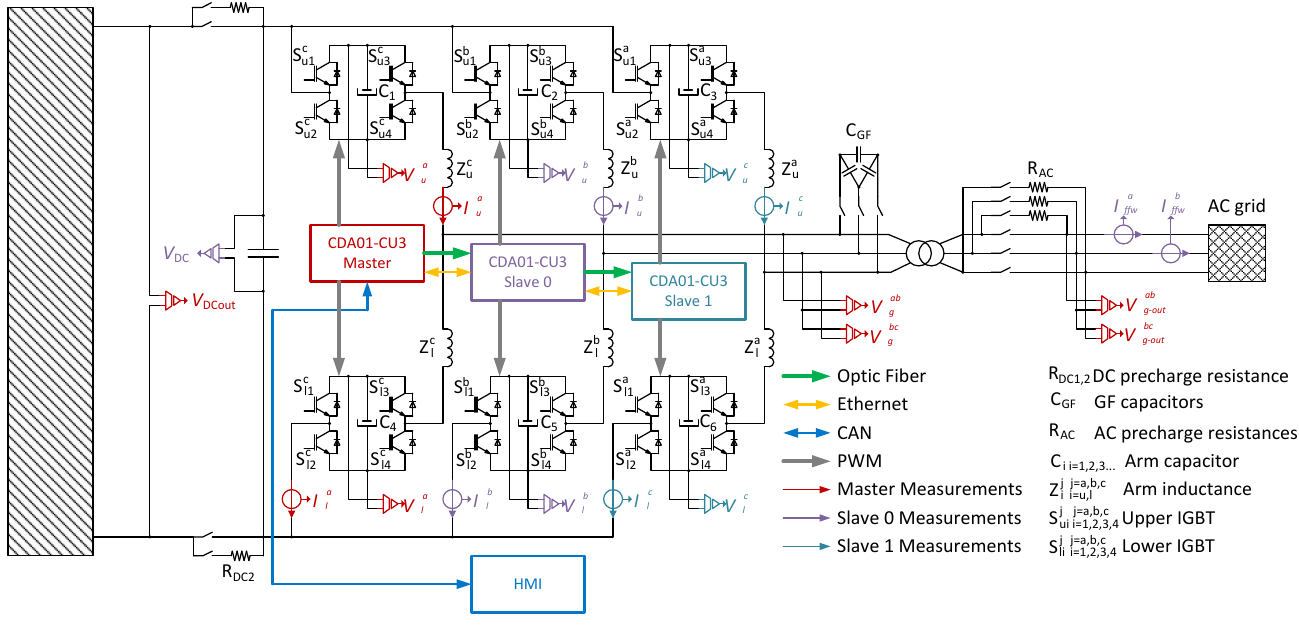
Figure 6. Overall scheme of the converter measurements, driving signals and